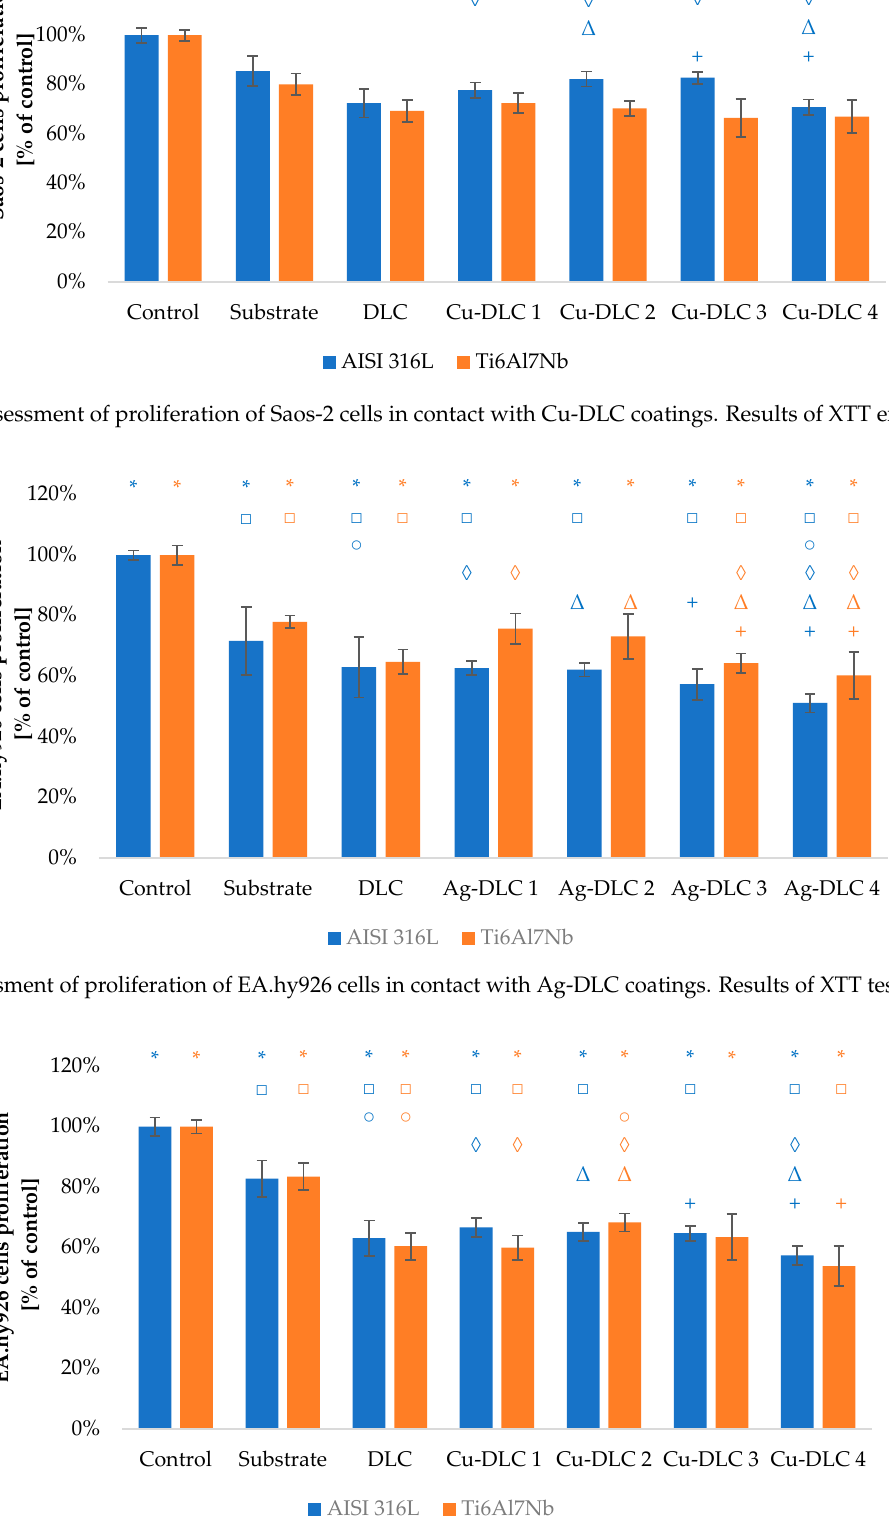
Figure 12. Assessment of proliferation of EA.hy926 cells in contact with Cu-DLC coatings. Results of XTT test examination. The addition of a small amount of copper to the carbon matrix (up to 4.74 at.%) improved proliferation ability of Saos-2 cells. Such effect was visible for samples Cu- DLC1, Cu-DLC2, and Cu-DLC3 but only for AISI 316 LVM substrate. The increase was on the level of 5–10% of control. In the case of titanium alloy as a substrate material, the statistically significant difference appeared only between samples DLC and Cu-DLC 1— an improvement of about 3%. No positive effect or even slight decrease of proliferation level in comparison to the un-doped sample was visible for Cu-DLC4 deposited on both substrate materials. Assessment of proliferation ability of EA.hy926 cells showed almost a depletion of cell viability with the increasing amount of silver in doped coatings. The depletion reached for Ag-DLC4 approximately 12% and 10%, respectively, for AISI 316LVM and TI6Al7Nb substrates. In the case of coatings deposited on stainless steel, the proliferation deterioration occurred even with the lowest amounts of admixture. For the second substrate, an improvement of viability of about 5% comparing to the control sample was observable for Ag-DLC1 and Ag-DLC2.